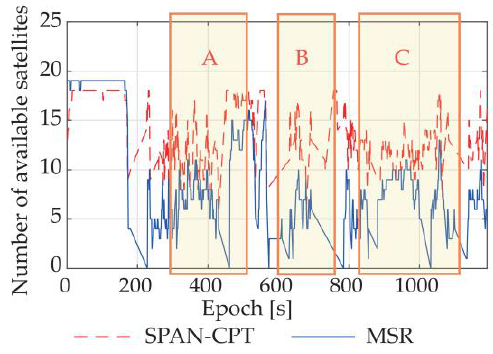
Figure 14. Available satellite numbers of SPAN-CPT and MSR.